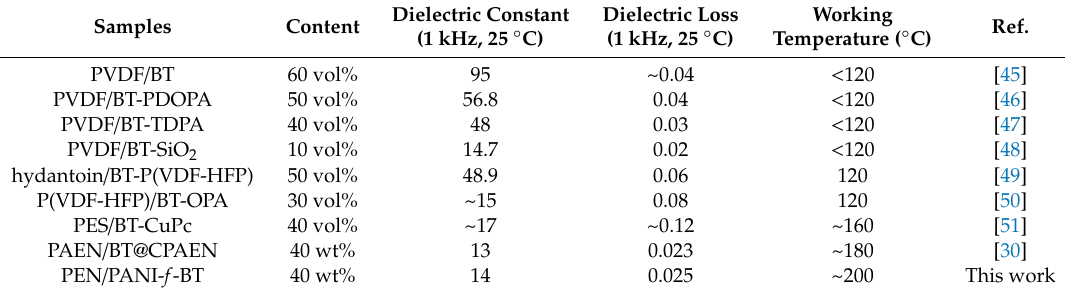
Table 2. Dielectric constant at 1 kHz and 25 ◦ C, dielectric loss at 1 kHz and 25 ◦ C, working temperature of typical polymer-based